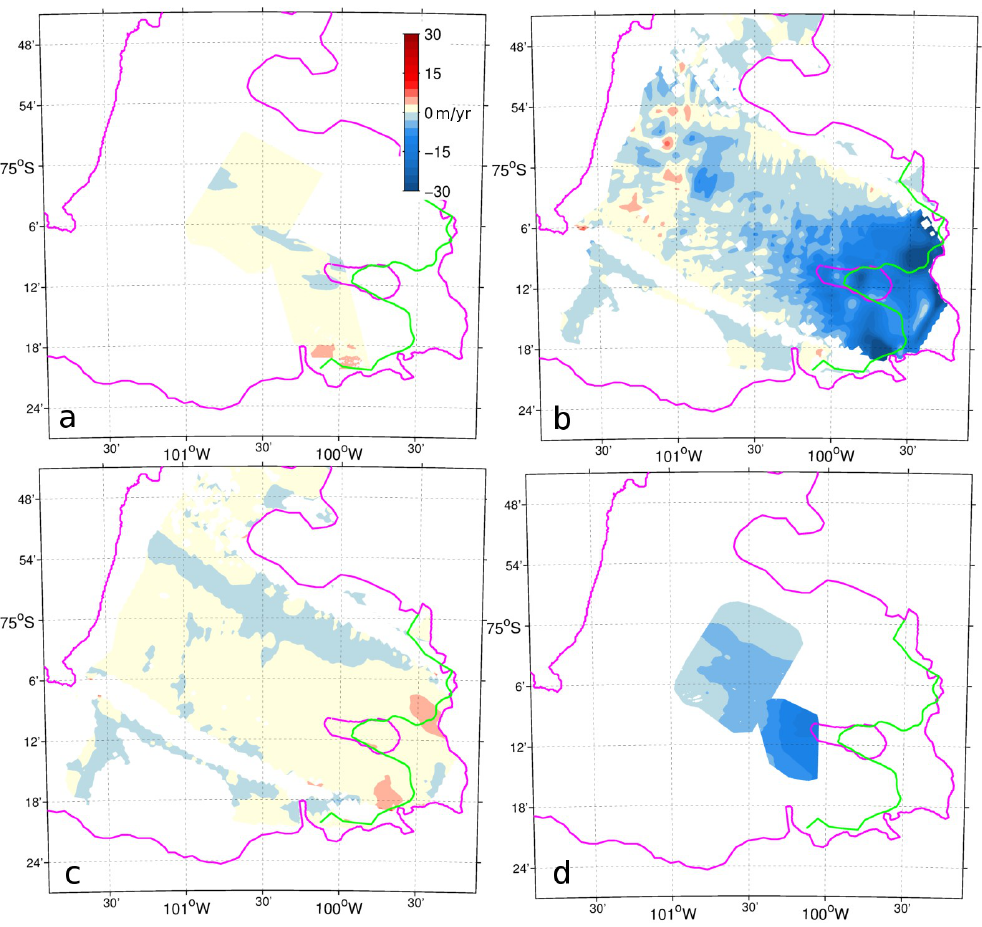
Fig. 2. Evaluation of the main terms in Eq. (7): the medium-scale Eulerian elevation change (a) , the medium-scale slope advection (b) , and the medium-scale divergence (c) and the medium-scale surface expression of basal melt (d) Figure 2 Evaluation of the main terms in equation 8: the medium-scale Eulerian elevation change (a), the medium-scale slope advection (b), and the medium-scale divergence (c) and the medium- scale surface expression of basal melt (d).